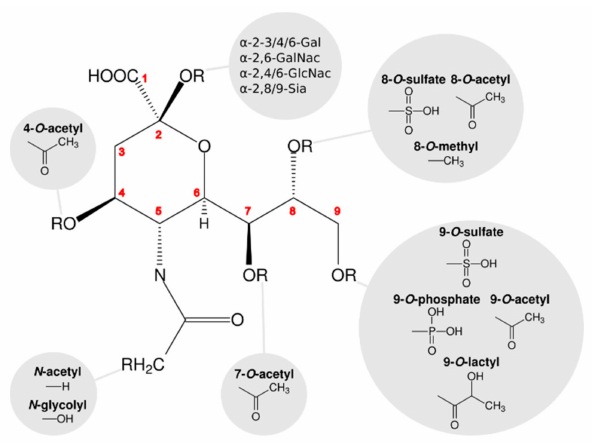
Figure 1. Schematic of sialic acid variants. The N -acetylneuraminic acid (Neu5Ac) sca ff old